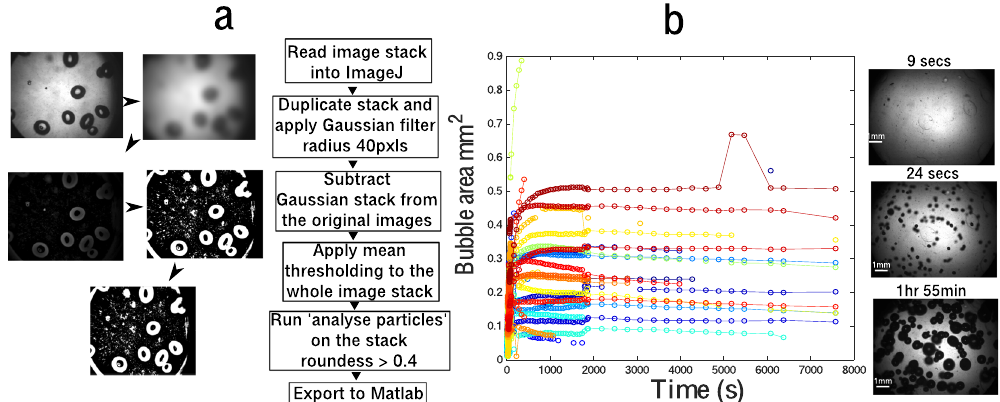
Figure 2. ( a ) Showing the segmentation and analysis process of bubbles that nucleate within the gels as a result of decompression from higher external pressure. ( b ) Showing representative images taken post decompression and a graph of the individual bubble radial trajectories that can be extracted from the images with the image anaylsis software.